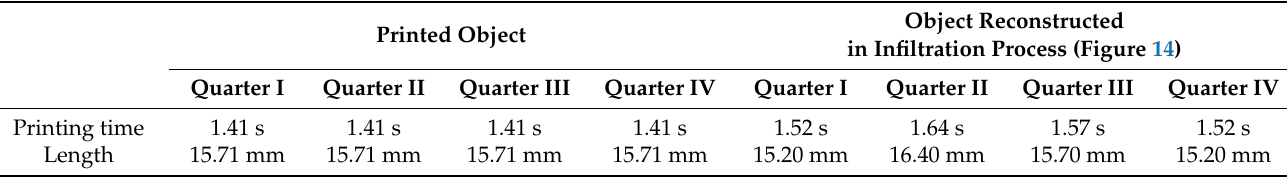
Table 2. The reproduction accuracy of the tube (Figure 7b).